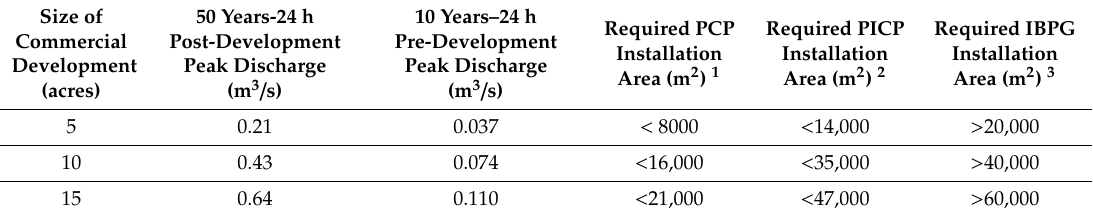
Table 5. Assessment of PCP installation size requirements to meet a 10-year storm event discharge goal for 5, 10, and 15 acres of commercial